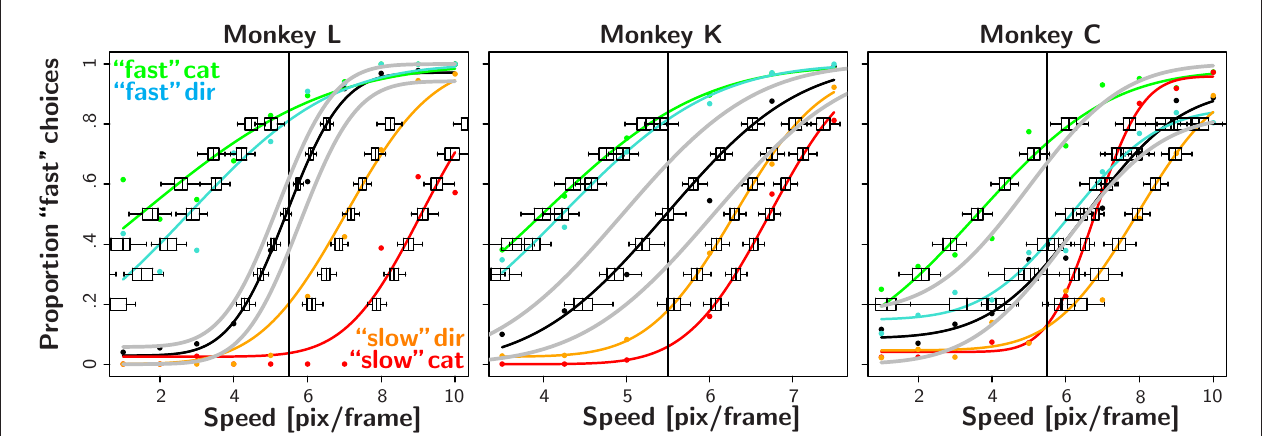
bias” condition corresponds to trials where the green target could be reached by a saccade in the biased direction. The orange and cyan color corresponds to the slow and fast direction bias, respectively. The box and whisker plots indicate confidence intervals of a bootstrap procedure (see Materials and Methods for details). The gray lines indicate the predictions of the ideal observer analysis which maximizes reward given the stimulus discriminability observed in the neutral condition. The results show a clear pattern: unbiased behavior in the neutral condition and large shifts of the PSE in the expected direction for the biased